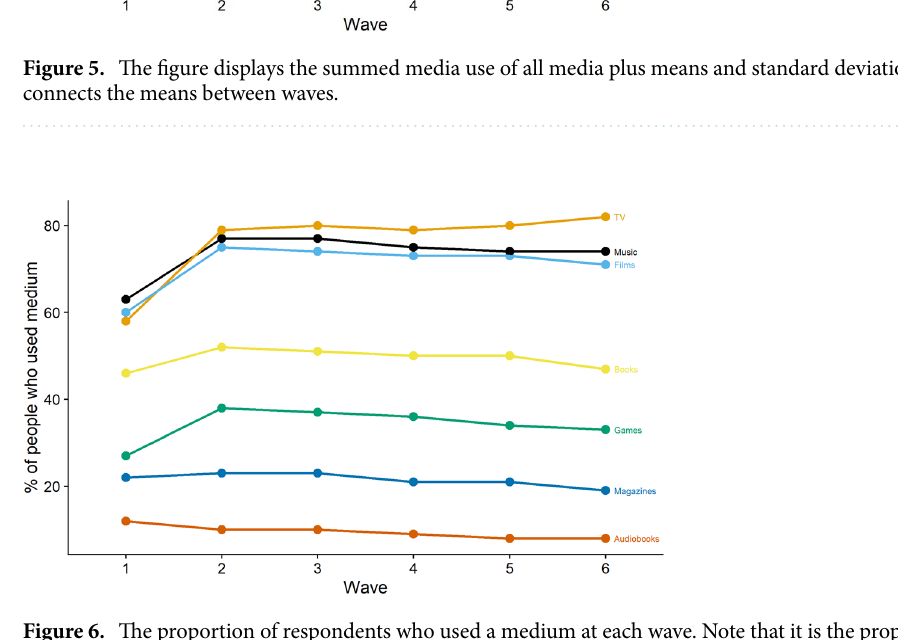
Figure 6. The proportion of respondents who used a medium at each wave. Note that it is the proportion of the final sample that we analyzed, so after exclusions and only those with at least three waves of